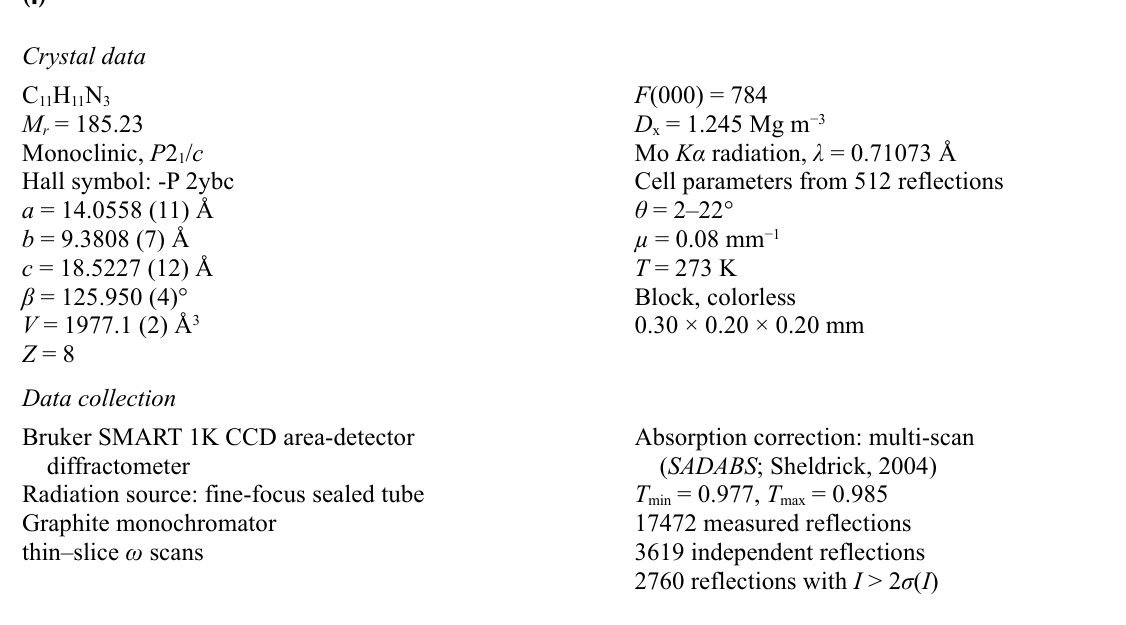
The packing of (I), showing one layer of molecules connected by N—H···N hydrogen bonds (dashed